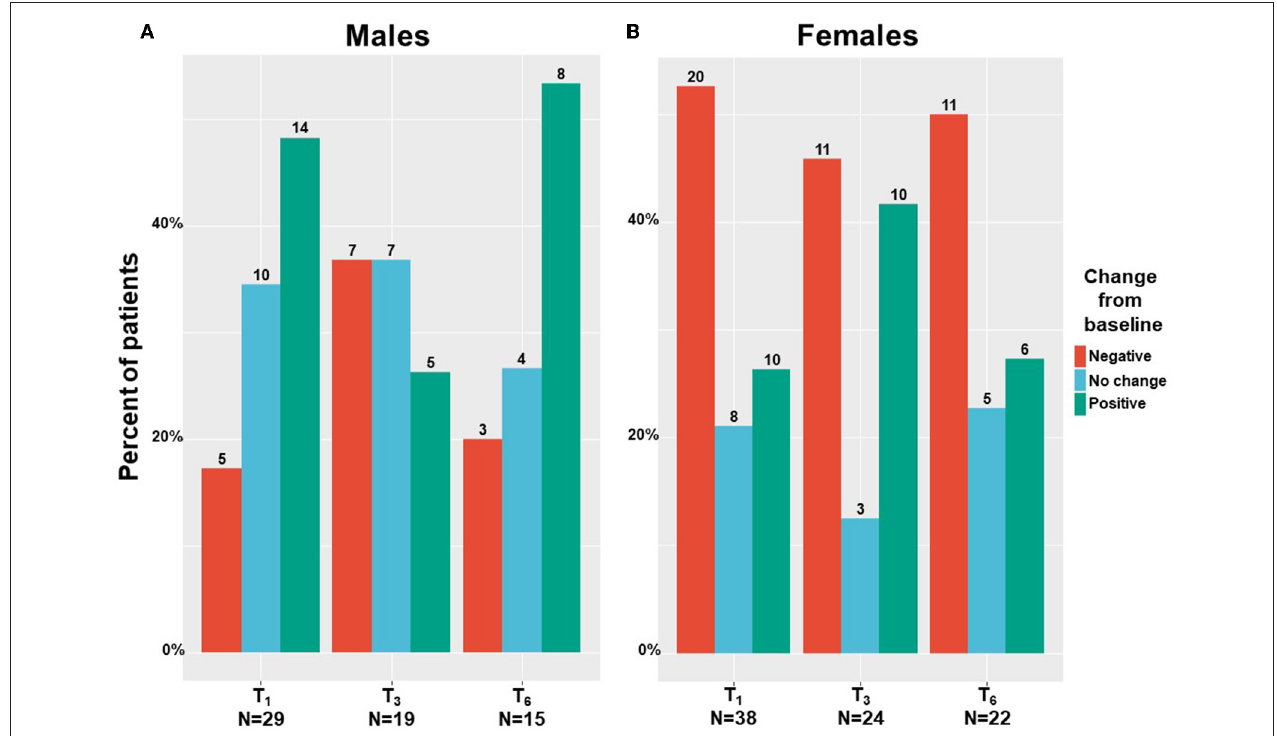
FIGURE 6 | Sexuality problems change during medical cannabis between sexes. T 1 , 1-month Follow-Up; T 3 , 3-month Follow-Up; T 6 , 6-month Follow-Up; numbers on bars represent the number of patients that reported.